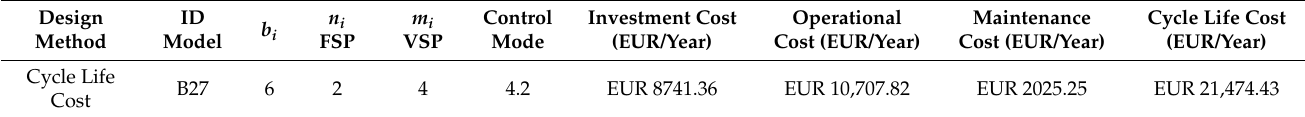
Table 17. Obtained results in (TF-PS1) in the second alternative of conventional design (fixing the number of pumps). Design